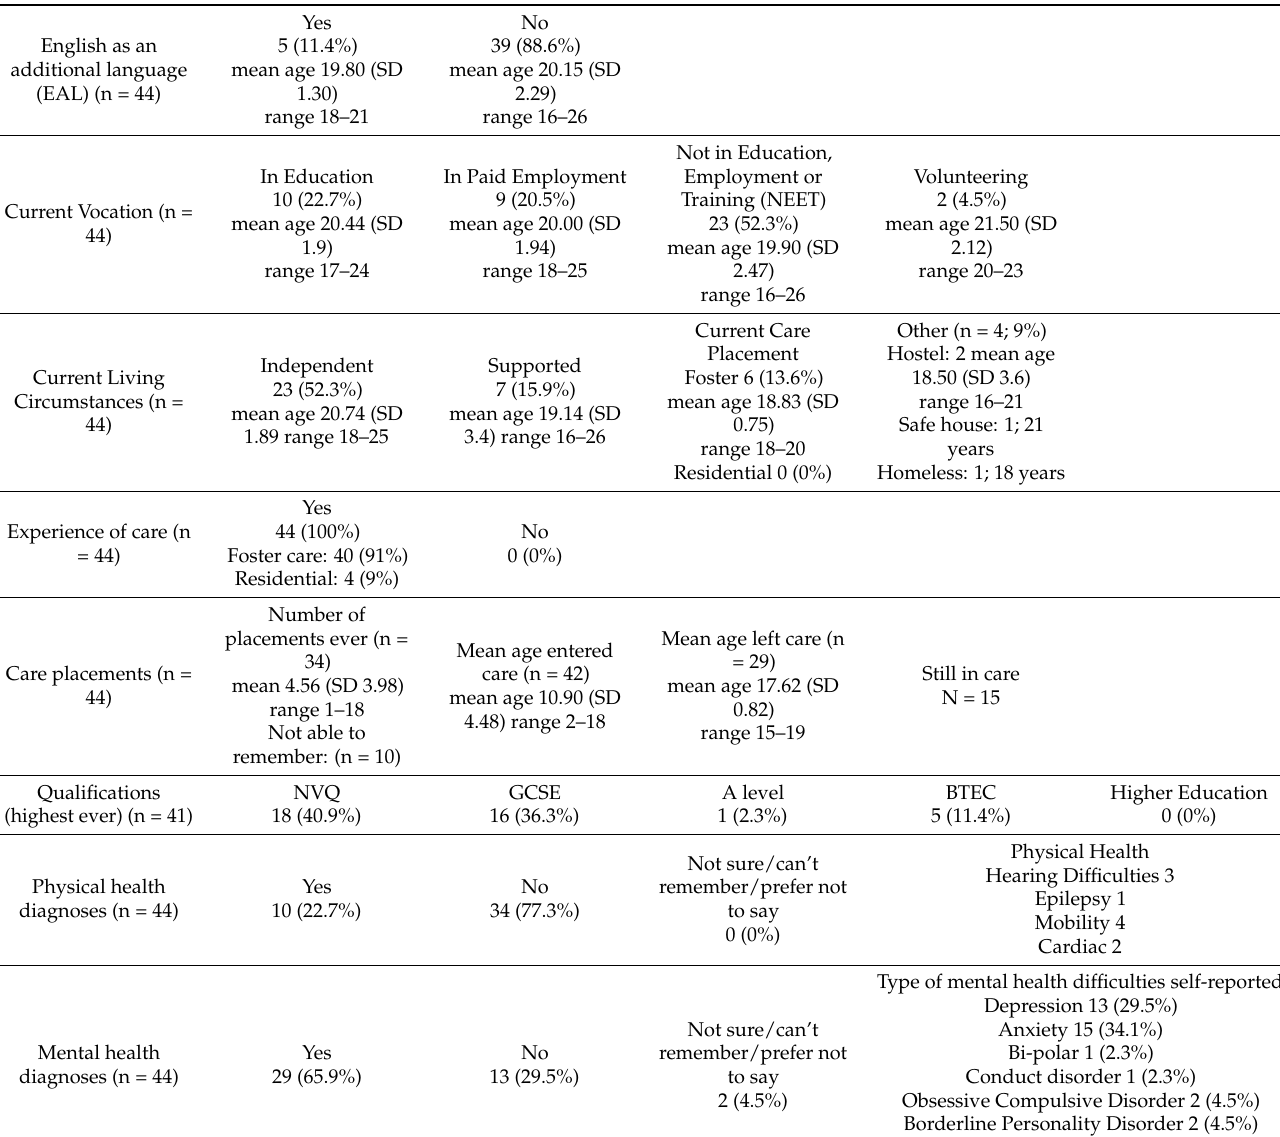
Table A1. Participants’ demographics via self report (n =